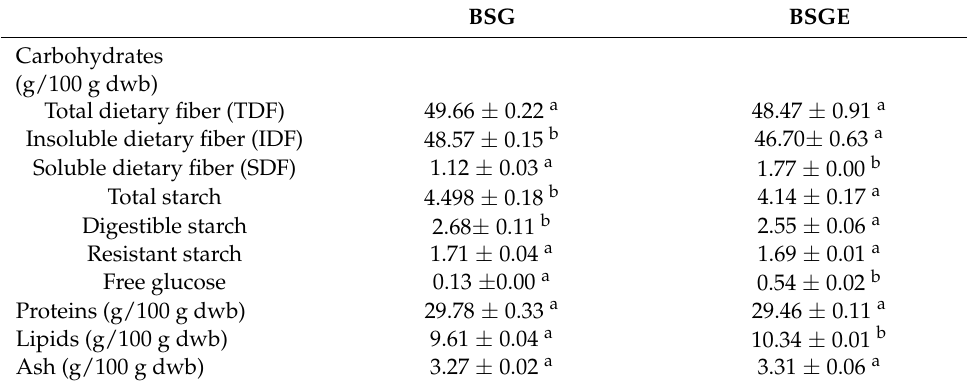
Table 3. Proximate composition of BSG and BSGE.